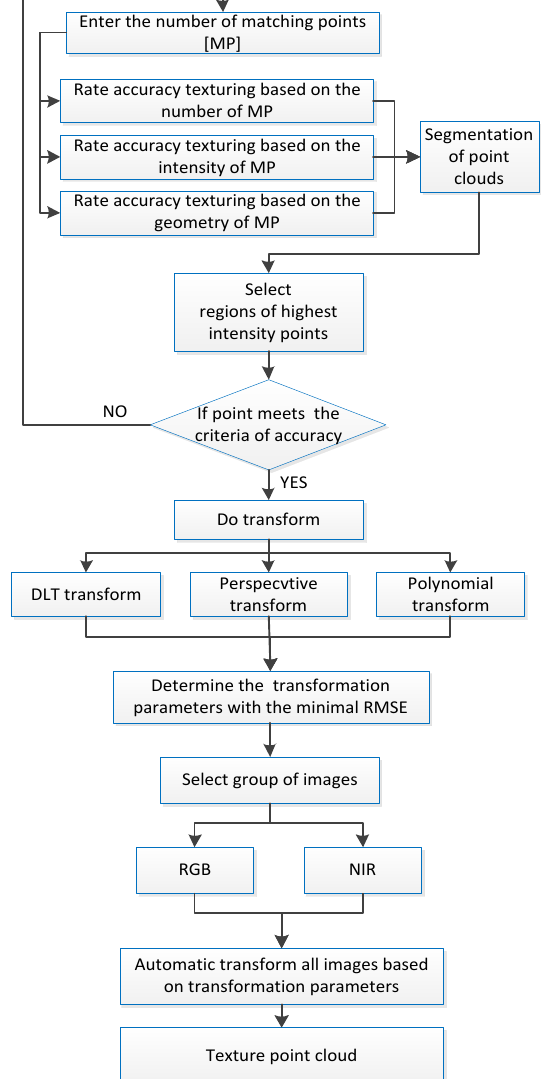
Figure 2. Diagram of conducted research